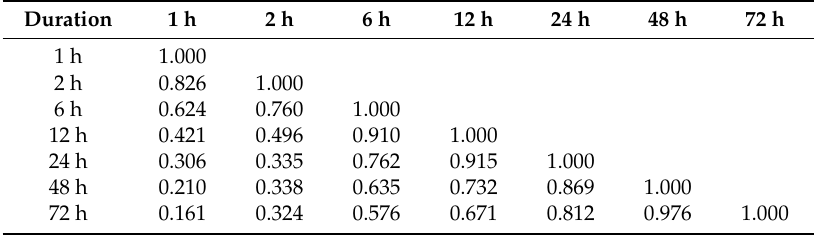
Table 4. Sample correlation coefficients between rainfall intensity of different